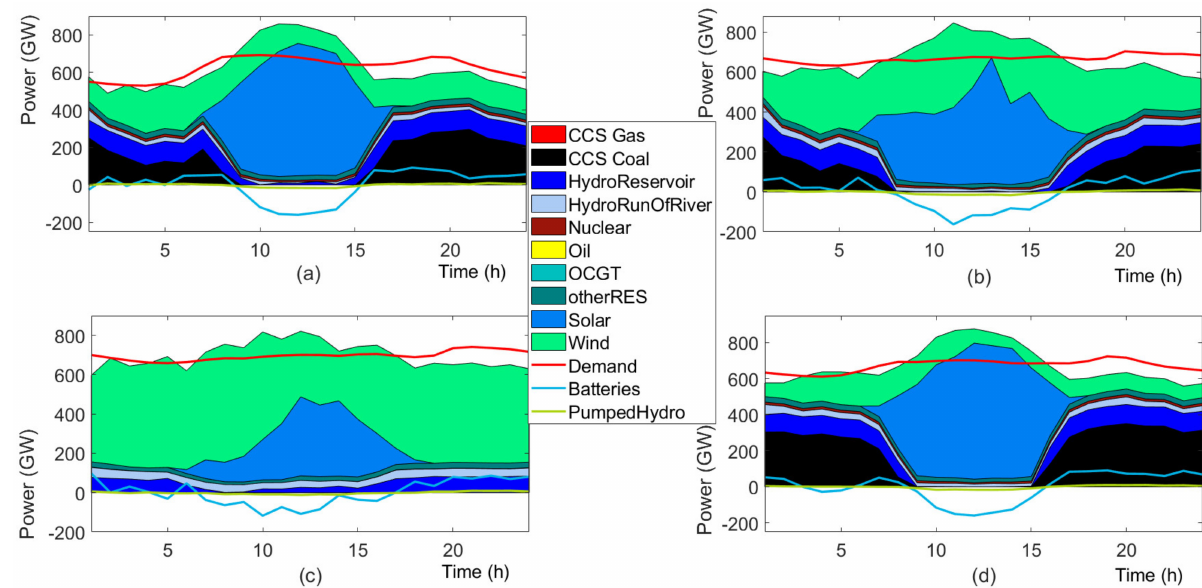
Figure 11. Generation mix in the year 2050 according to scenario 4 (specifically, scenario-tree node 11), with the availability of storage, in four typical days. Figure ( a ) reports a typical day within the period January–March, ( b ) a typical day within April–June, ( c ) a typical day within July–September, and ( d ) a typical day within October–December.